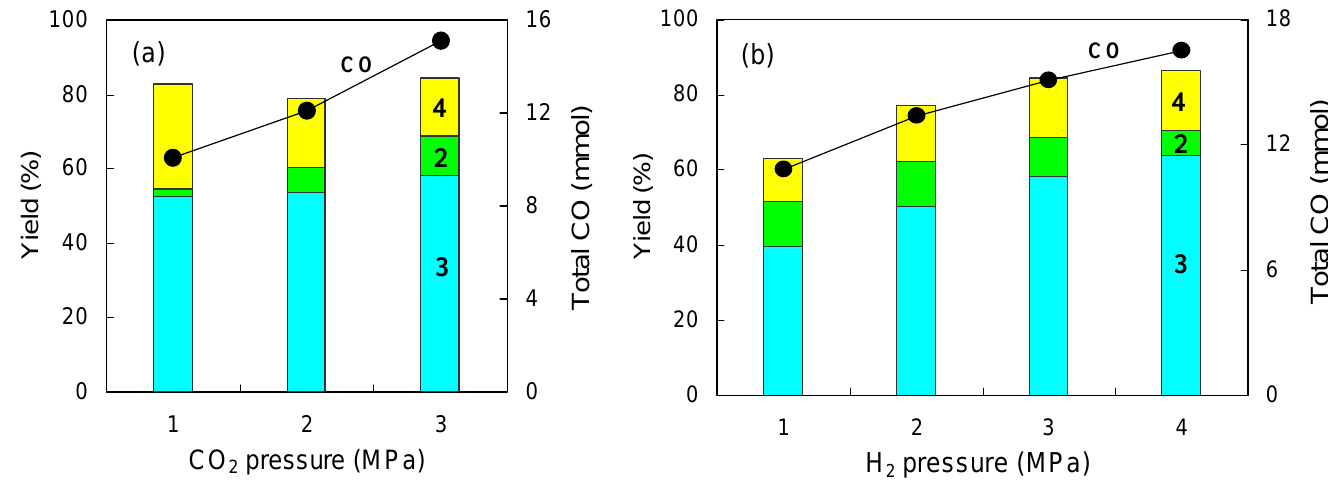
Figure 2 . Influence of total pressure of CO Ru (CO) 0.3 mmol, additive LiCl 0.4 mmol, substrate cyclohexene 1 cm 3 (9.87 mmol), solvent NMP 3 12 8 cm 3 , temperature 423 K, time 3 h. 2 : cyclohexanecarboxaldehyde,